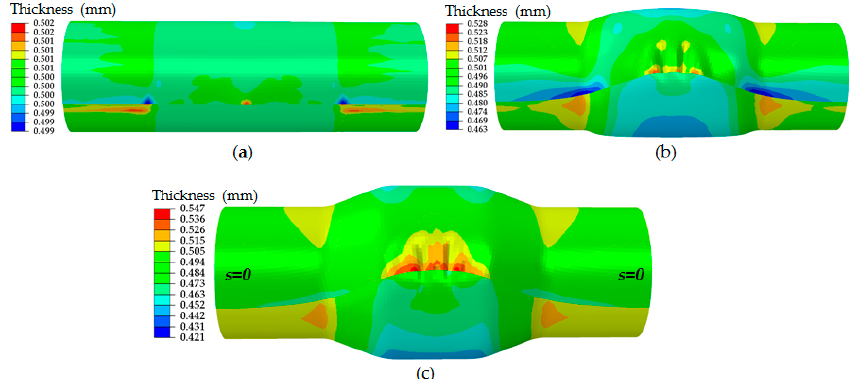
Figure 11. Hydroforming of overlapping blank with axial constraint ends ( a ) p = 2.0 MPa; ( b ) p = 5.0 MPa; ( c ) p = 9.0 MPa.